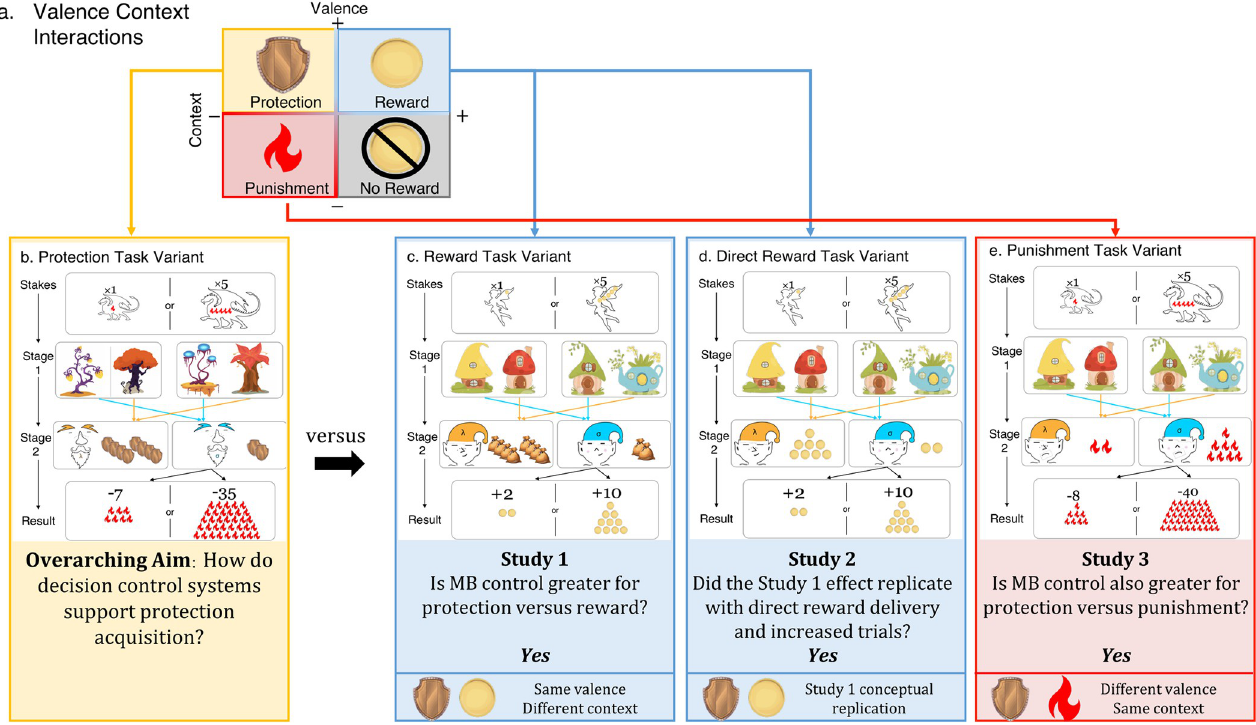
Fig 1. Study structure. (a) Protection acquisition shares positive valence features with appetitive reward and negative context features with aversive punishment. The context-valence asymmetry of protection acquisition was hypothesized to be reflected in distinct engagement of decision control systems compared with stimuli in consistently appetitive or aversive domains. All studies included the (b) protection acquisition task variant and a comparison task variant: (c) reward acquisition in Study 1, (d) direct reward acquisition in Study 2, and (e) punishment avoidance in Study 3. Study 1 compared protection and reward (b versus c) using abbreviated task versions comprised of 100 non-practice trials. Study 2 compared protection and direct reward (b versus d) using longer task versions comprised of 200 non-practice trials. Study 3 compared protection and punishment (b versus e) using the longer task versions comprised of 200 non-practice trials. Deterministic transition structures are depicted with blue and orange arrows and indicate that the same first-stage state always leads to the same second-stage state. At the start of each trial, subjects saw the stakes amplifier, which showed “x1” for low-stake trials or “x5” for high-stake trials. Low-stakes results ranged from 0–9 units whereas high-stakes results ranged from 0–45 units. The stakes amplifier was applied to the punishment/reward available on that trial as well as the final result received. Next, subjects saw one of two pairs of first-stage dwellings (e.g., trees or houses). After subjects chose between the left and right dwelling depicted, they transitioned to the second-stage creature (e.g., gnomes or elves). Second-stage creatures delivered outcomes in the form of shields (protection), sacks (reward), coins (direct reward), or flames (punishment). At the second-stage, subjects received outcomes ranging between 0–9 according to a drifting outcome rate. Outcomes changed slowly over the course of the task according to independent Gaussian random walks ( σ = 2) with reflecting bounds at 0 and 9 to encourage learning throughout. Outcomes were multiplied by stakes and presented as final results applied to the maximum reward/penalty available on each trial. For example, in panel (b), subjects visited the low-payoff second-stage gnome. This gnome delivered two shields. When two shields were delivered on a low-stakes trial, which had the threat of 9 dragon flames, the end result was 7 flames (9 minus 2). When two shields were delivered on a high-stakes trial, which had a threat of 45 dragon flames (9 flames multiplied by the stakes amplifier of 5), the end result was 35 flames (45 minus 10, 10 is calculated from 2 shields multiplied by the stakes amplifier of 5).